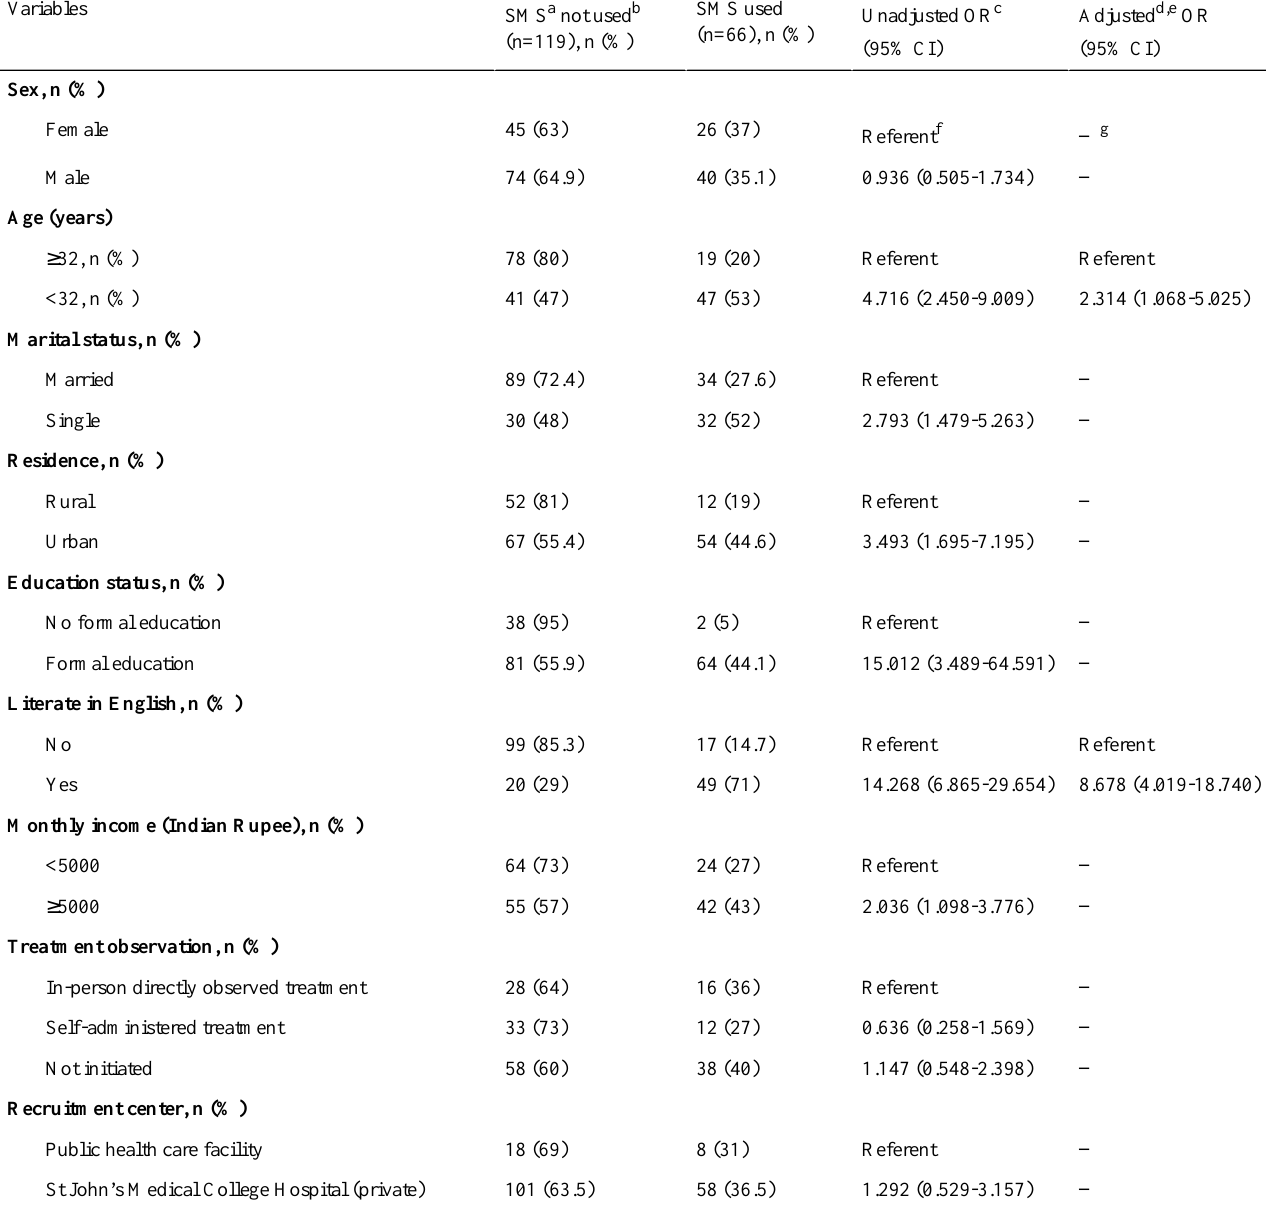
Table 3. Use of text messaging and its association with demographic characteristics